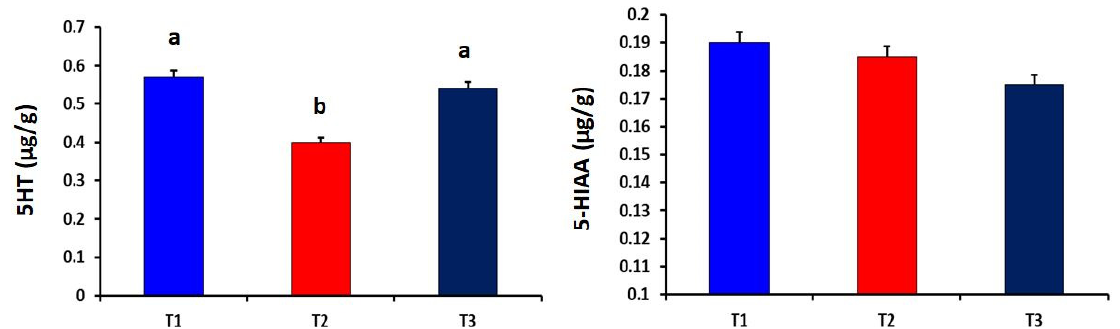
Figure 4. Effect of dietary curcumin supplementation on the levels of serotonin (5-HT) and 5-hydroxyindoleacetic acid (5-HIAA) in brain tissues of heat-stressed broiler chickens ( p = 0.006 and 0.132, respectively). a,b Values within a row with different superscripts differ